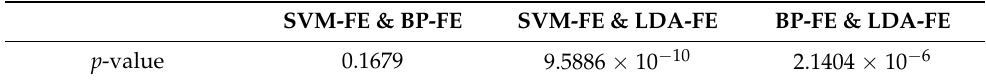
Table 11. p -values in significance